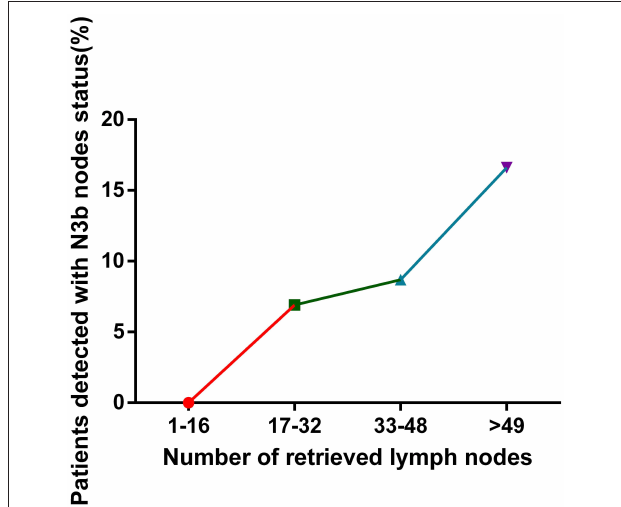
FIGURE 5 | Relationship between the number of retrieved lymph nodes and the rate of the detection of N3b status.